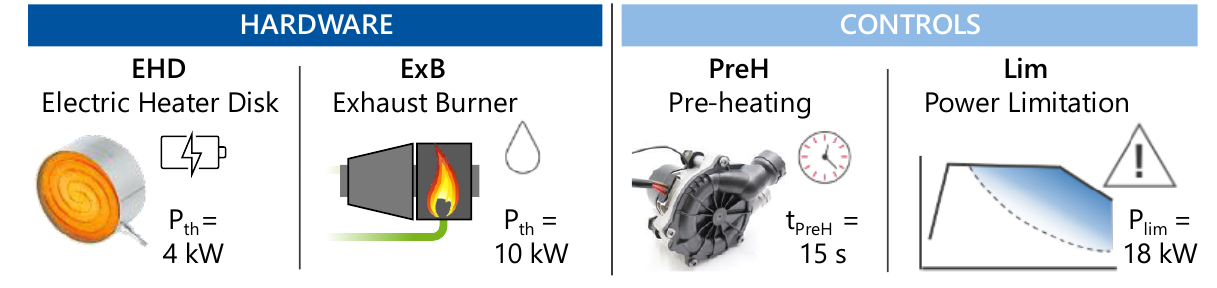
Figure 9. Major hardware and control measures discussed to reduce cold start emissions.